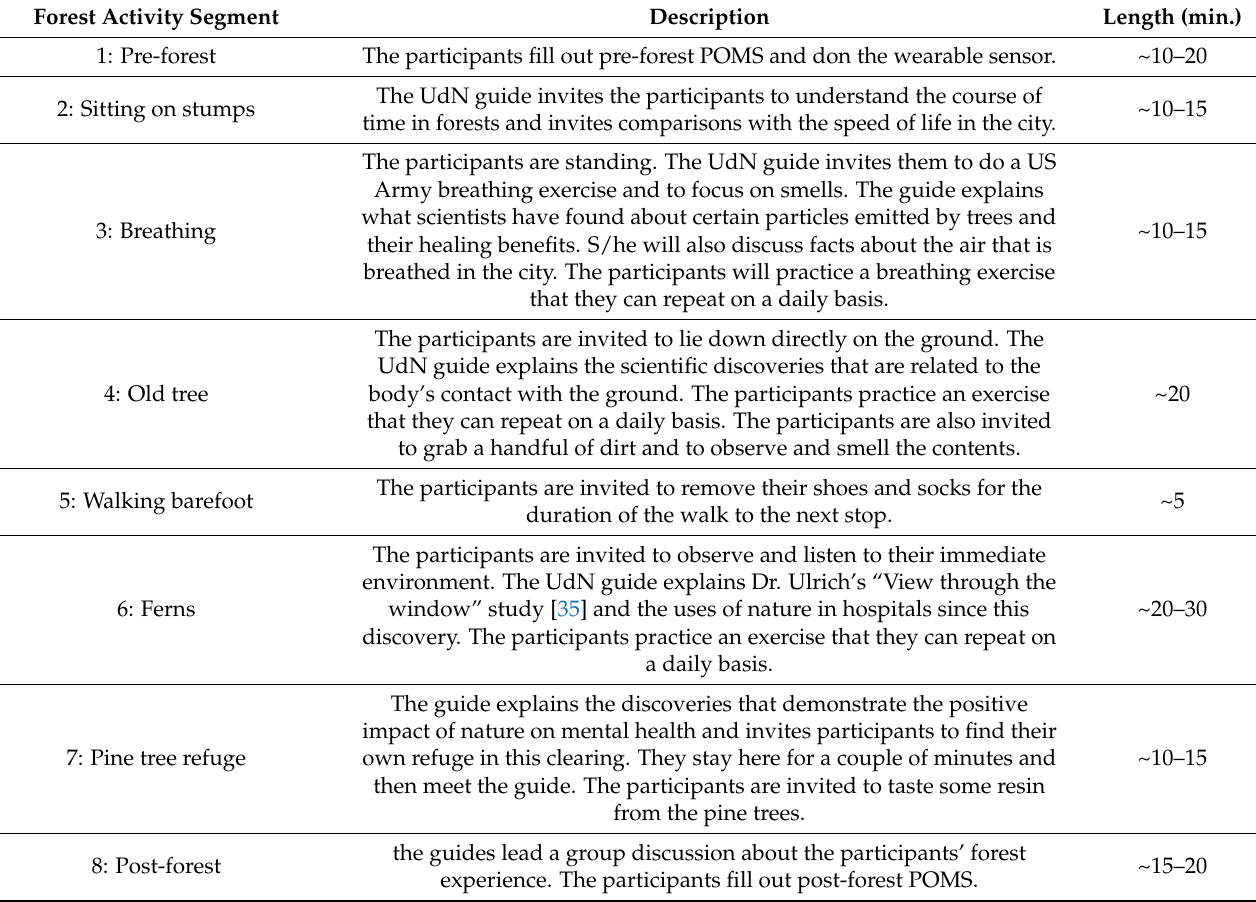
Table 1. Description of segments in the Nature Break